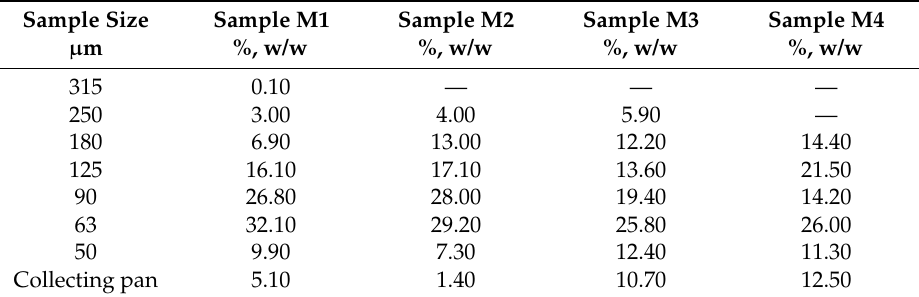
Table 1. Comparison between the distribution size of soils milled by the centrifugal mill equipped with a 12 ribs rotor and 500 µ m trapezoidal sieve ring, M1 and M2 samples, and the planetary mill equipped with a single agate jar, M3 and M4 samples.